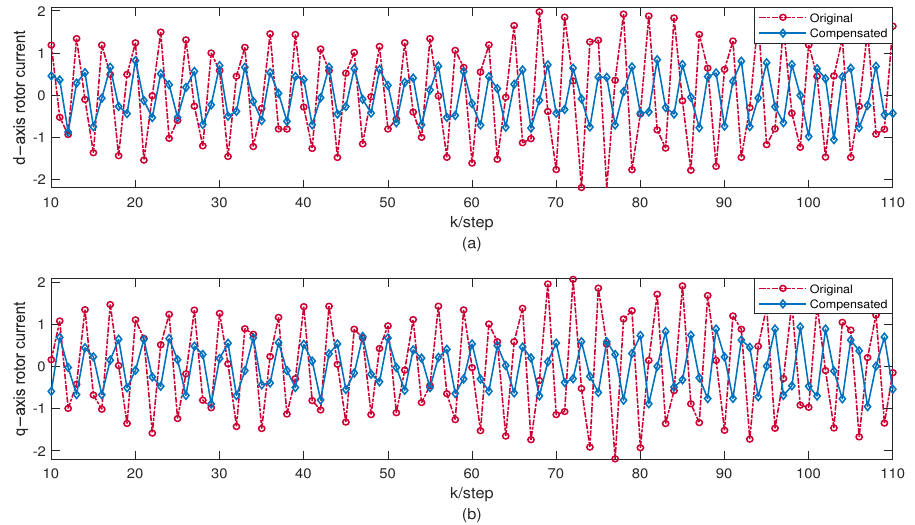
Figure 4. Trajectories of rotor current under the controller without compensation and with compensa- tion. ( a ) Comparison of estimated mean square error of state. ( b ) Comparison of the estimated mean square error of